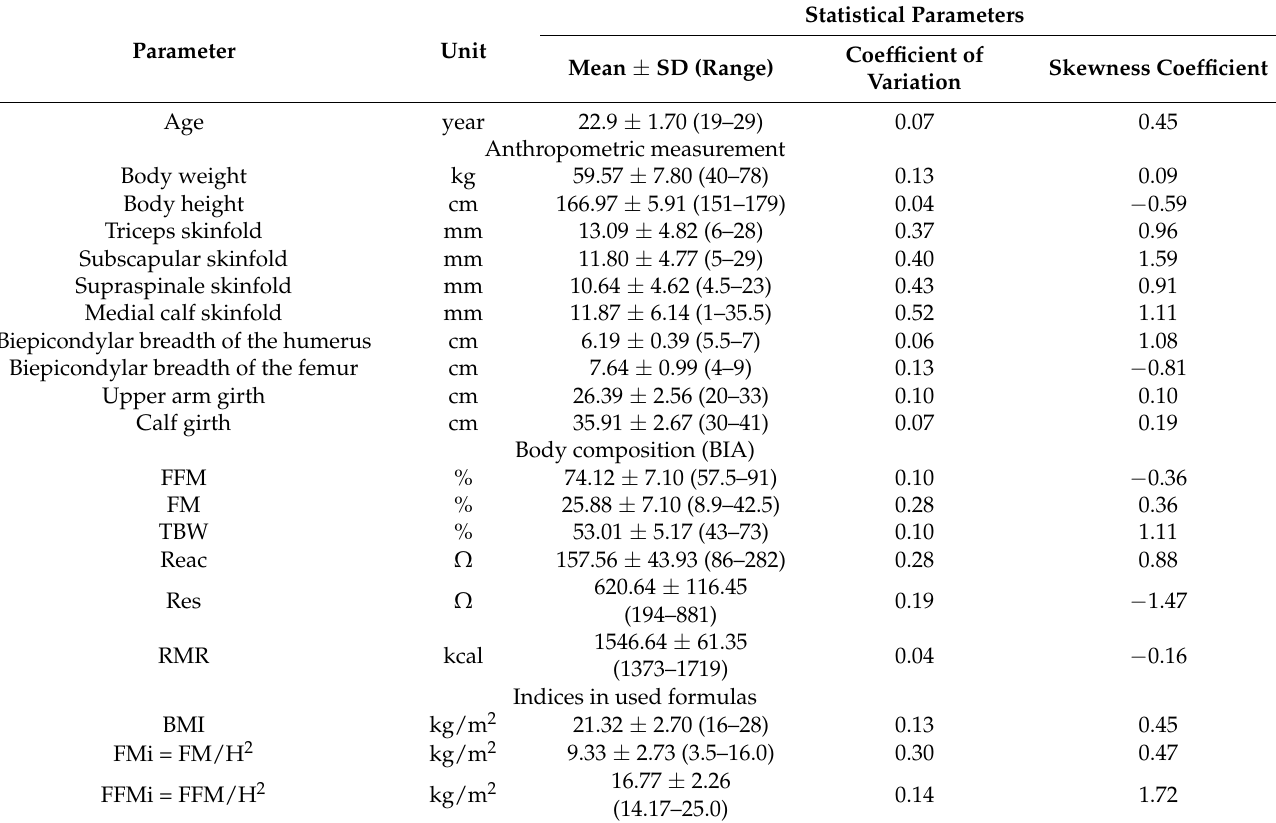
Table 1. Group characteristic and statistical parameters of the used